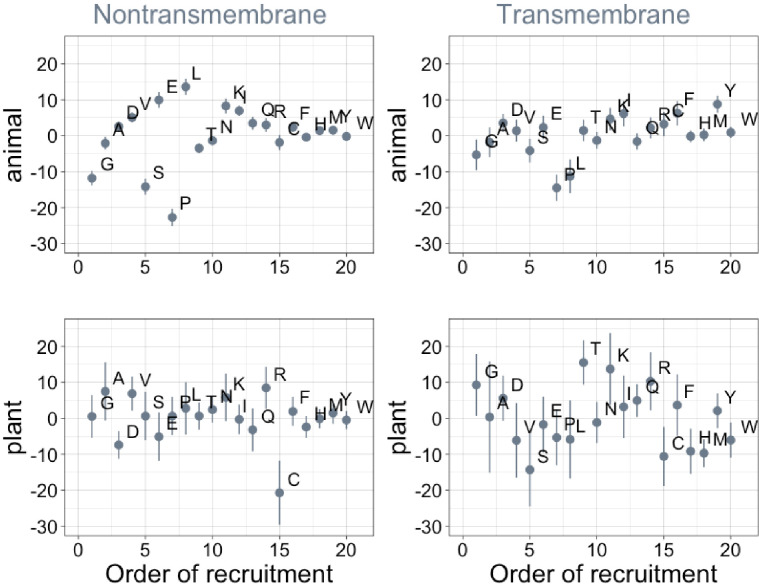
Order of amino acid recruitment does not affect domain composition in more recent lineages.Phylostratigraphy slopes are in units of percentage points of composition per billion years. Lines indicate the standard errors on the slopes. ‘Animal’ (nontransmembrane and transmembrane Spearman’s p = 0.6 and 0.07) and ‘plant’ (nontransmembrane and transmembrane Spearman’s ρ = 0.5 and 0.5) slopes are calculated over pfams appearing after the divergence between the animal/fungi and plant lineages, 1496 MY, assessed in only animal or only plant instances.